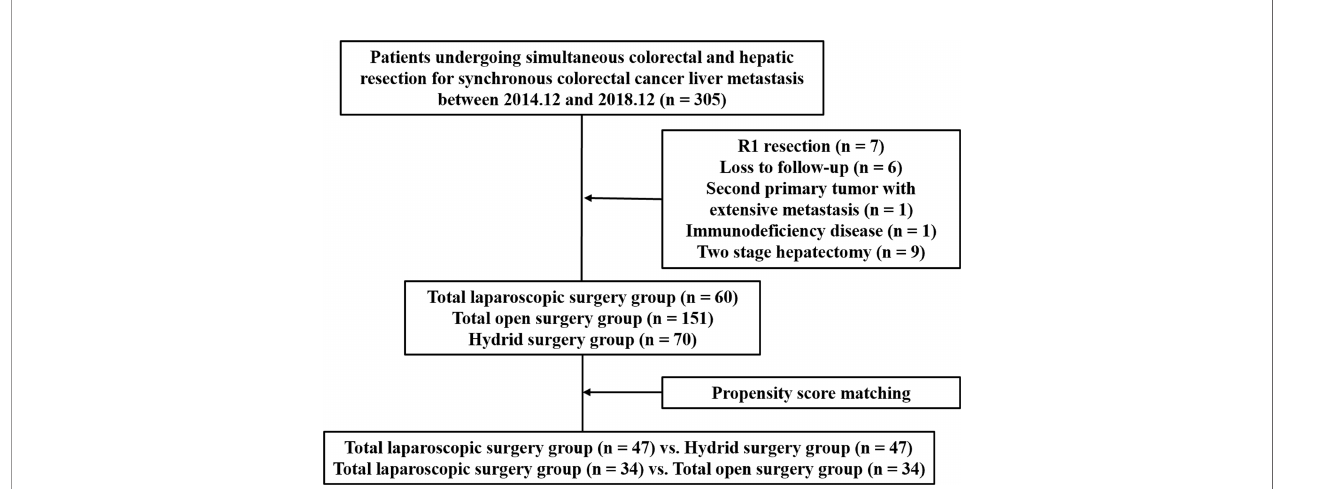
FIGURE 1 | The fl owchart of this